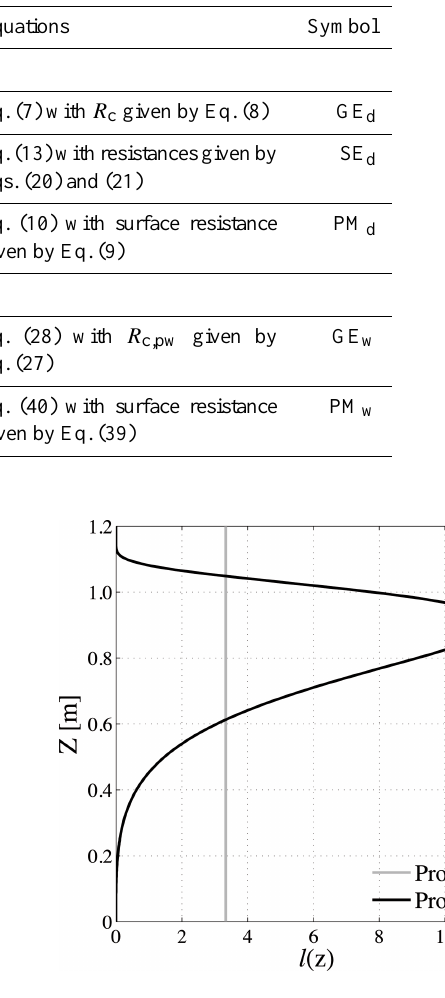
Fig. 2. Profiles of leaf area density considered in the simulation process: (A) constant profile and (B) profile adapted from a gamma function with a higher leaf area density in the top